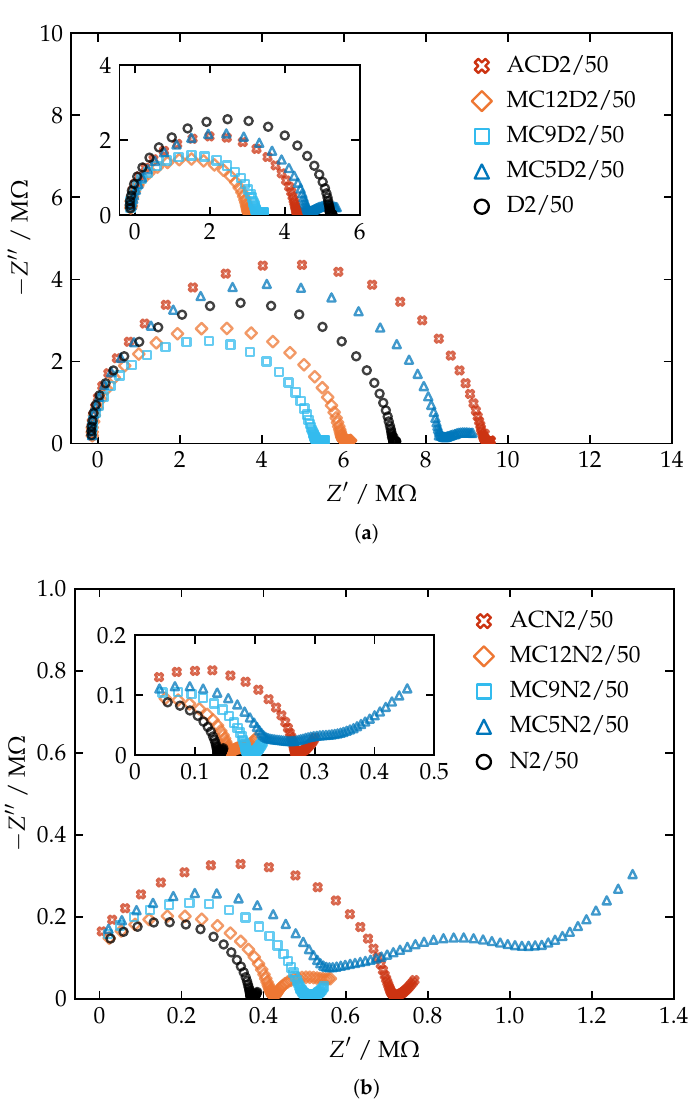
Figure A1. Impedance spectra of sensors with membranes containing 2wt.% ionophore, 50mol.% (relative to the ionophore) TDMACl, and either ( a ) DOS or ( b ) o -NPOE as the plasticizer. PVC-shelled sensors are shown in the main plots and PCTFE-shelled sensors in the insets. Measurements were performed in 10 − 1 M sodium acetate with the parameters f = 100mHz–100kHz, E dc = 0V vs OCP, and ∆ E ac = 100mV ( RMS ) . See Table 1 for membrane compositions.